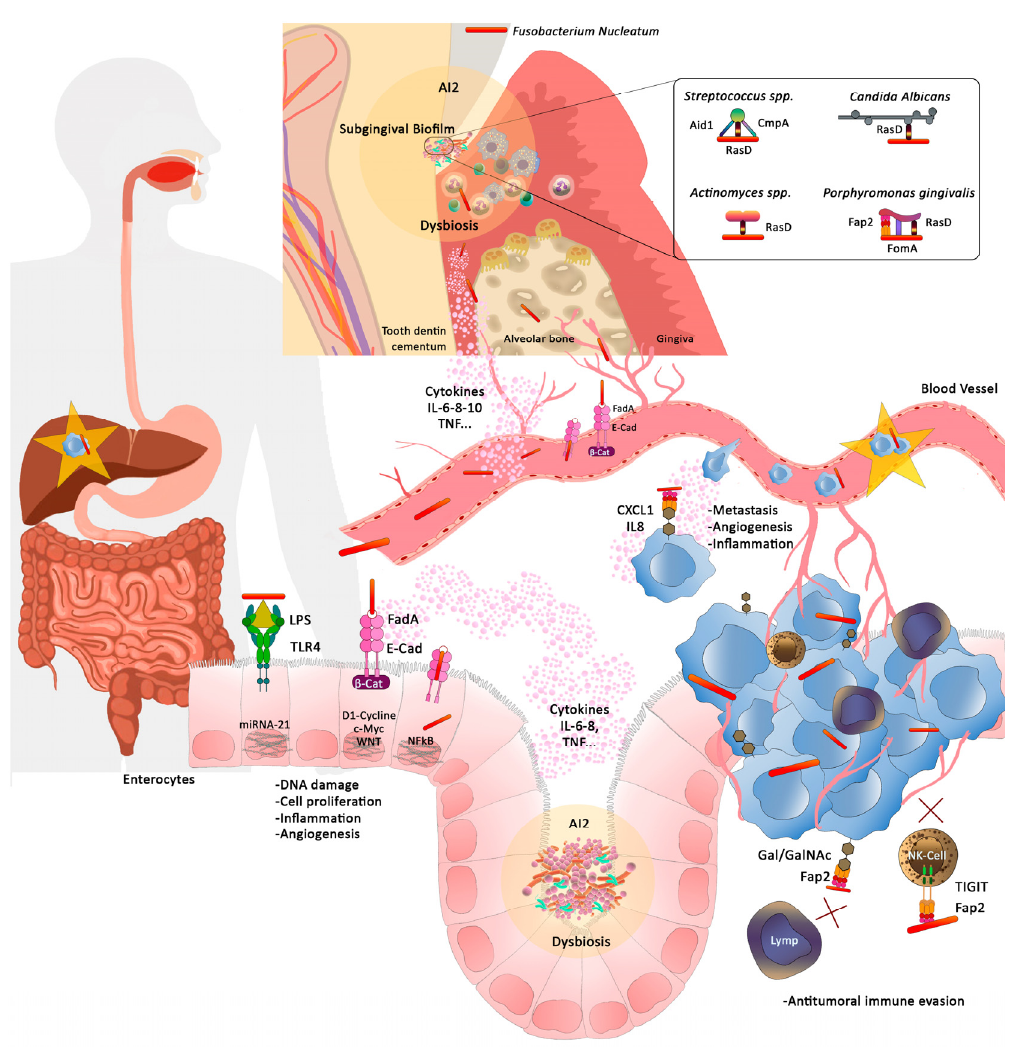
Figure 2. Upper section: Fusobacterium nucleatum (Fn) is involved in the formation of the subgingival biofilm by aggregating with primary and secondary colonisers and other species such as Candida albicans. through adhesin RasD. It leads the subgingival biofilm towards a dysbiosis state through